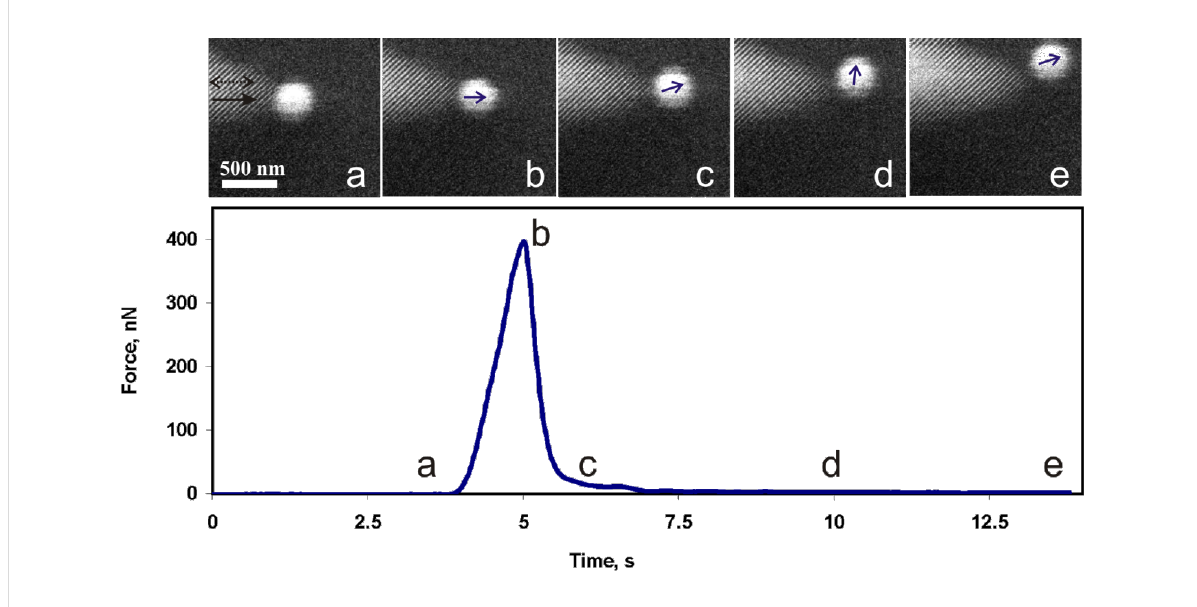
Figure 6: Snapshots of the manipulation of a Ag NP by using an AFM tip, and the corresponding force curve. The black solid arrow in image (a) indi- cates the tip movement direction and the dashed arrow shows the tip oscillation direction. The small blue arrows indicate NP displacement directions (b, c, d, e).